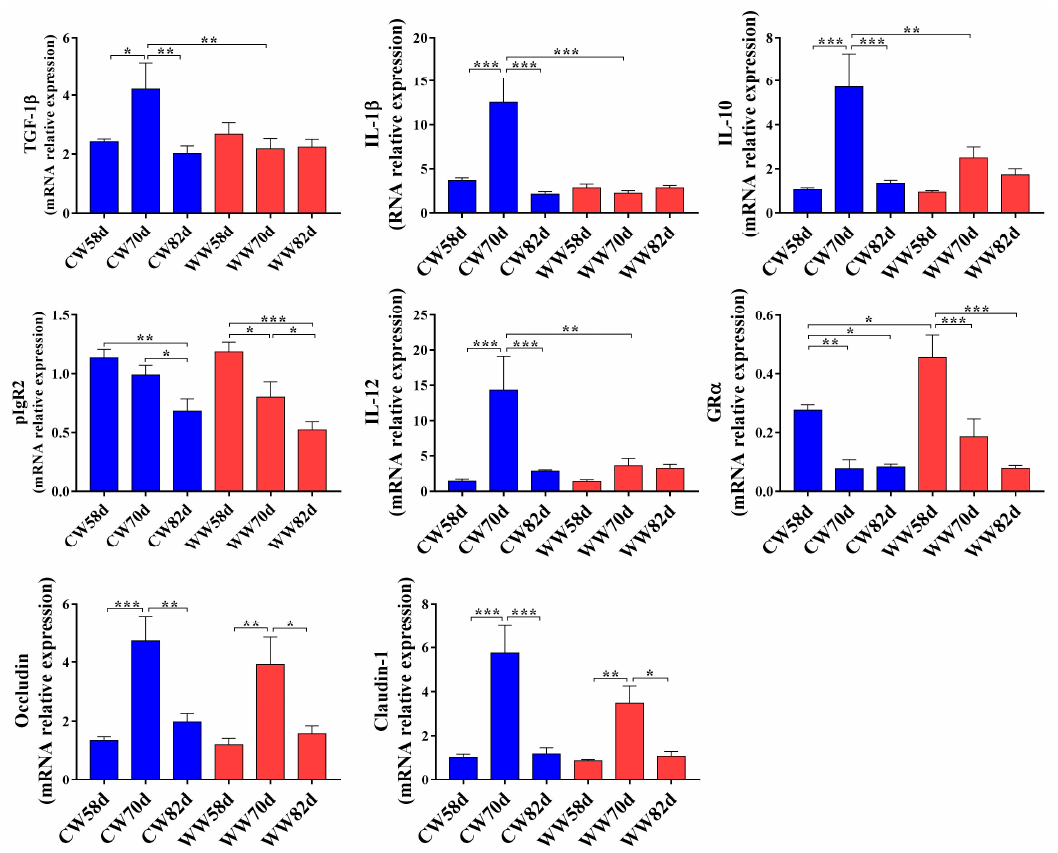
Figure 2. Effects of drinking warm water on intestinal immune function and expression of tight junction genes ( n = 8). CW, cold water group; WW, warm water group. * p < 0.05, ** p < 0.01, *** p < 0.001. Values are shown as means ± SEM. Differences were analyzed by one-way analysis of variance followed by the least-significant difference post hoc test.